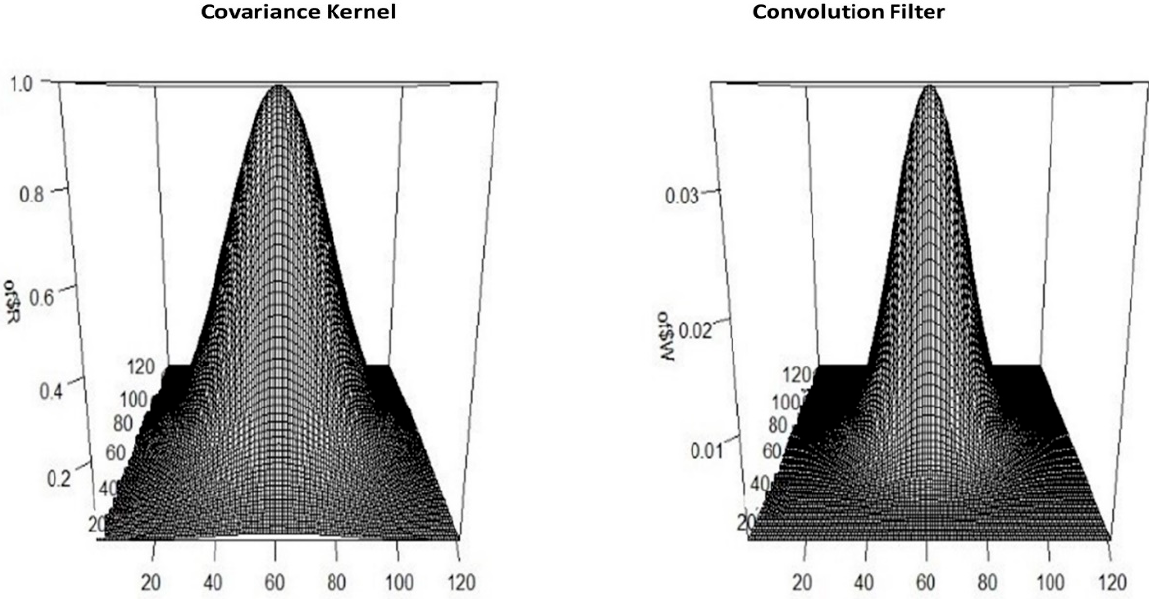
Figure 3. The autocorrelated Gaussian covariance process and its associated convolution filter. This filter is passed over spatially random Gaussian noise to produce rasters with the desired spatial structure.